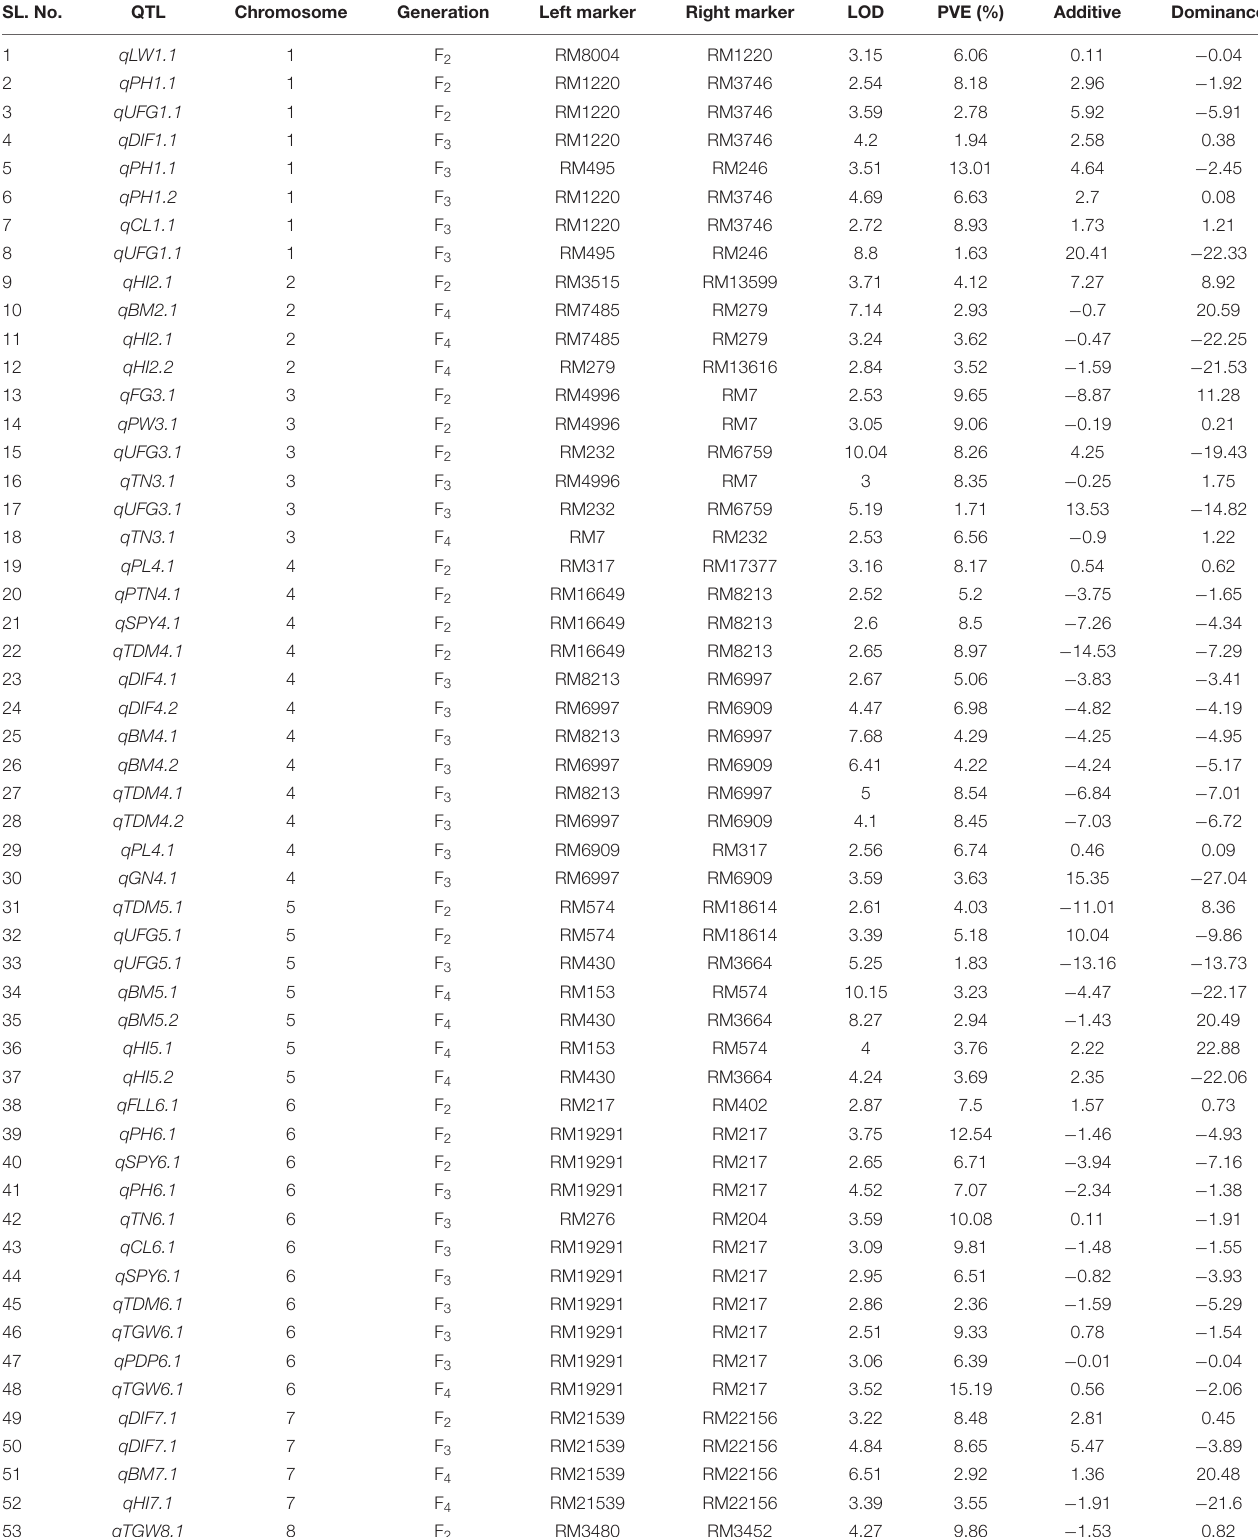
TABLE 3 | Additive and dominance effects of quantitative trait loci (QTLs) identified for yield-related traits in F 2 , F 2 : 3 , and F 2 : 4 populations of 166s × 14s using ICIM. SL.